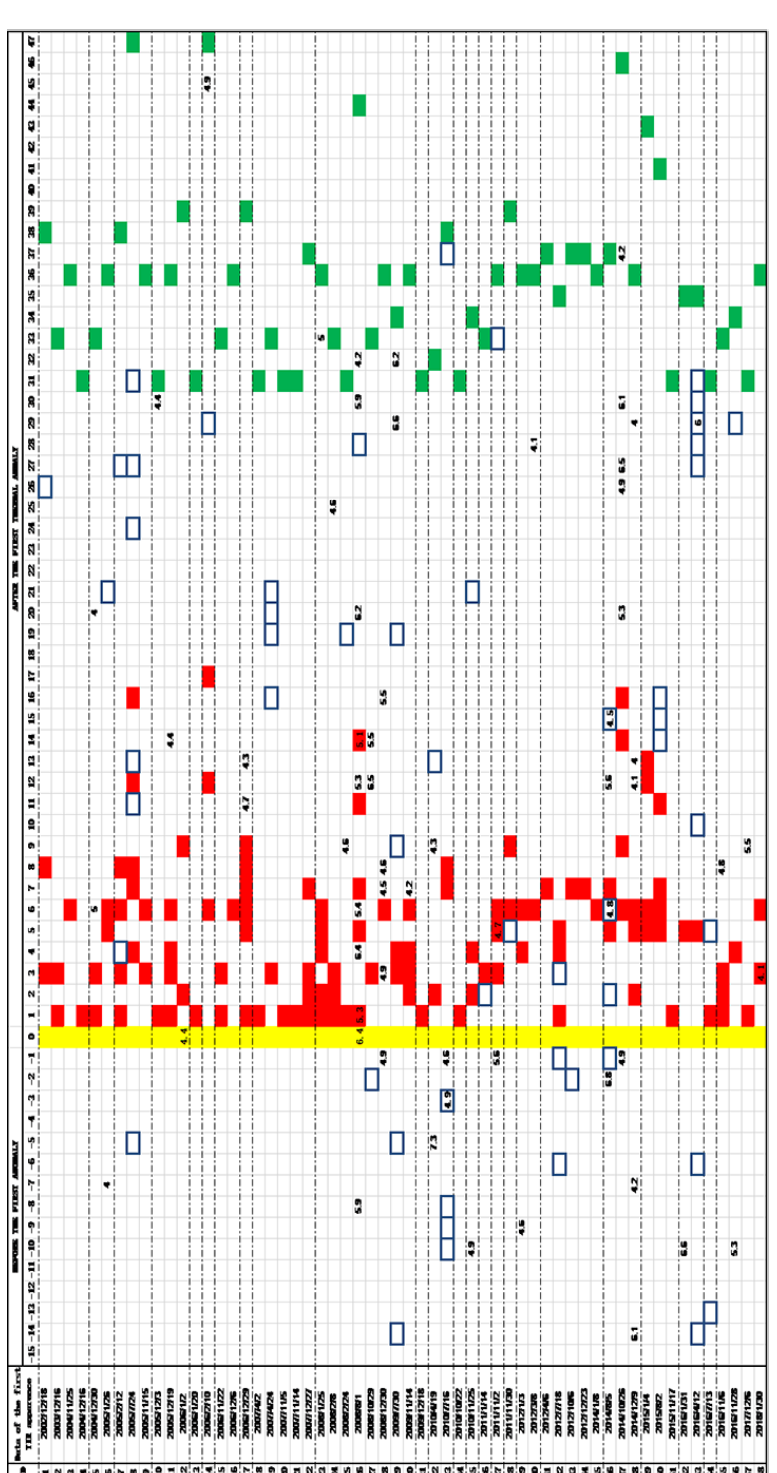
Figure 5. Correlation analysis among TIR anomalies and earthquakes with magnitude bigger than 4.0 in the Sichuan area from Septem- ber 2002 to March 2018. All 61 TIR anomalies are identified, and each row corresponds to one TIR anomaly. The first day of the TIR anomaly is shown in yellow, while the red cells denote the ensuing persistence. The cells in the blue rectangle indicate that this day is affected by a large area of cloud cover, and the green cell is the final limitation for each anomaly. Cells with numbers indicate days of occurrence and magnitude of seismic events. The rows in the dotted box mean that there is no earthquake corresponding to this TIR